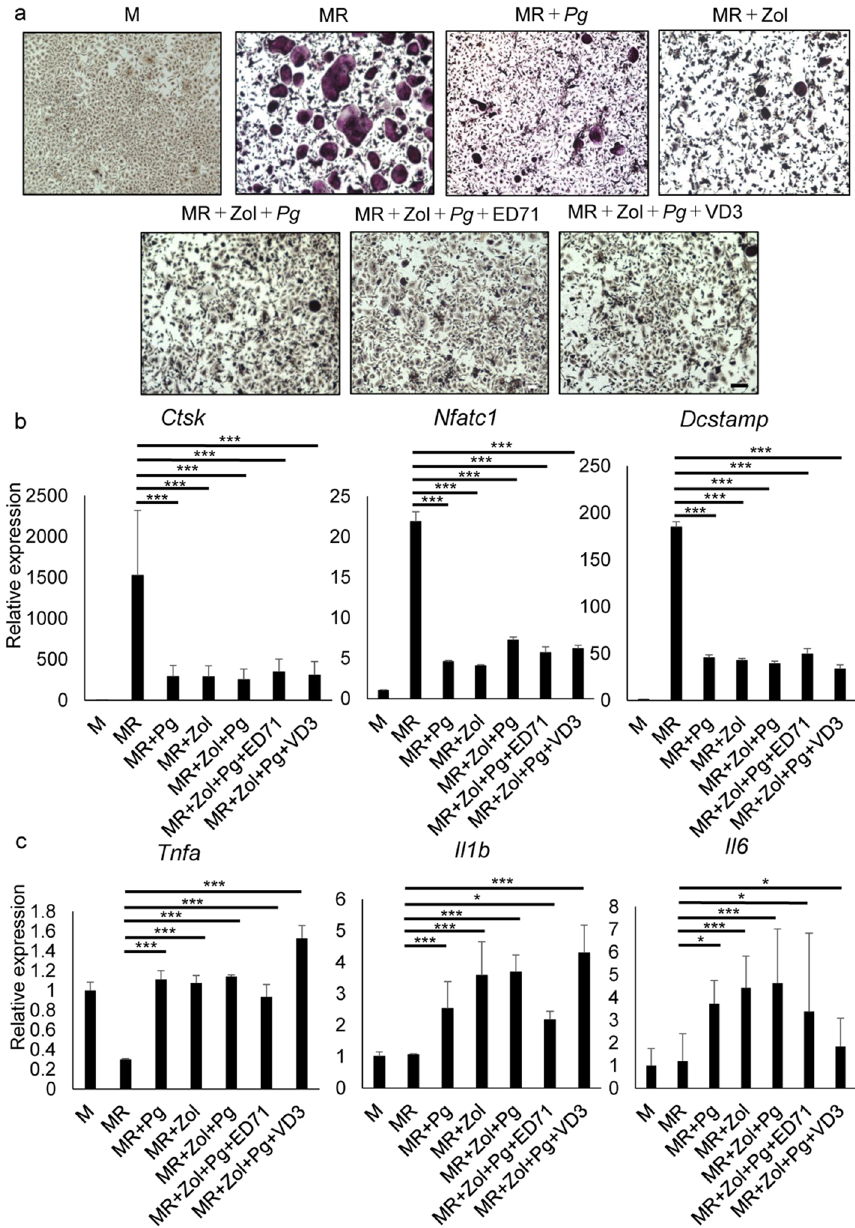
Figure 3. Treatment of osteoclast progenitors with Porphyromonas gingivalis extract inhibits osteoclastogenesis and VD3 or ED71 increases inflammatory cytokine expression. Osteoclast progenitors were isolated from wild-type mice and cultured in the presence or absence of M-CSF (M) or M-CSF (M) and RANKL (R) with or without 0.2 μg/ml zoledronate (Zol) with or without either ED71(10 -6 M) or VD3 (10 -6 M) and/ or Porphyromonas gingivalis extract (Pg). Osteoclast formation was evaluated by TRAP staining ( a ) or by quantitative RT-PCR to analyze expression of indicated markers. Tnfa, Il6, and Il1b expression in indicated groups of progenitor cells, as evaluated by quantitative RT-PCR ( b , c ). Scale bar = 100 μm. Data represent mean indicated transcript levels relative to Actb ± SD (each with n = 3, *P < 0.05; ***P < 0.001; NS, not significant, by ANOVA). Representative data are shown of at least two independent and identical experiments each with n =